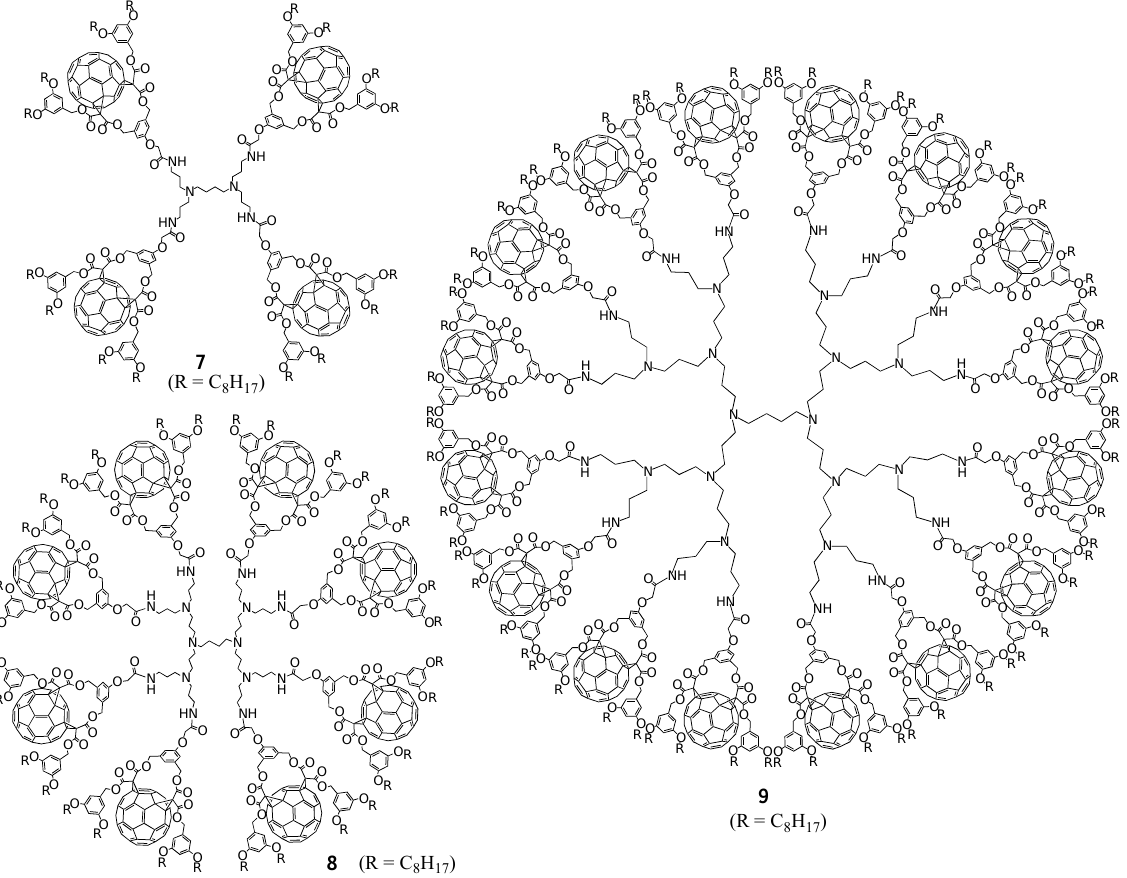
Figure 1. Structures of fullerene-rich PPI-derived dendrimers 7 - 9